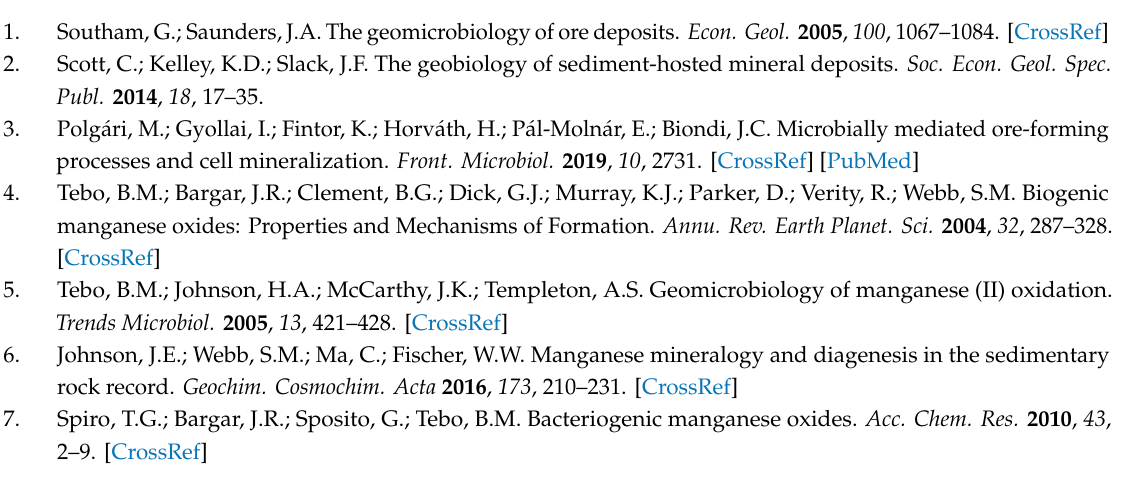
tu ff host (Vani vein / Figure 5). (B) MISS type: Nodules. Loaf- to mound-shaped structures with nodular and cauliflower-like thrombolytic surface fabric (VA-05-16 / Table S1). (C) MISS Type: Mat fragments and chips. Plan view of upper bedding surface of unmineralized sandstone / sandy tu ff covered by large patches of millimeter-thick Mn crusts, with highly irregular outlines and embayments, crosscut by white smoker–type hydrothermal-exhalative barite (-silica) feeder veinlets (black arrows). Chisel is 21 cm long (SMO-05-10 / Table S1). (D) MISS type: Mat-Layer Structure. Upper bedding surface showing “mat layer structure.” Concentric rims with crenulated appearance and discoidal colony texture (dotted line) (VA-05-05 / Table S1). (E) MISS type: Upturned and Curled Margins. Cracks with upturned and curled margins on upper surface of fine-grained Mn sandstone / sandy tu ff . Curved and upturned (involute) margin (arrow) of inferred fossil microbial mat consists of Mn-rich sandstone. Chisel in C is 21 cm (MI-04-27 / Table S1). (F) Mn sandstone / sandy tu ff -chimney. Tubular cone possibly representing a white smoker structure, consisting of erratic and locally patchy amounts of Mn oxides and barite that cement epiclastic sandstone / sandy tu ff ; knolls of Mn oxide minerals are adhering to the outer surface and tip of cone (VA-05-06 / Table S1). Number of analysed sample / Table with mineralogical composition or Figure with EPR analysis, Figure S2: Representative X-ray powder di ff raction pattern obtained for todorokite (T)-rich samples, Figure S3: Representative X-ray powder di ff raction patterns obtained for manjiroite(M)-rich samples [80], Figure S4: (A) SEM-backscattered electron (BSE) image of elongated fibres of crystalline todorokite ( > 5 µ m) intergrown within a platy todorokite matrix, which cement K-feldspar microclasts (K); (B) field-emission gun scanning electron microscope (FEG-SEM) image of nanocrystalline todorokite in the form of fibrous needles ( < 0.4 µ m) intergrown within a platy Mn oxide matrix; these fibres appear to be aggregated into a dense network of fibres displaying a plate-like growth morphology, which is characteristic of synthetic todorokite transformed from birnessite [75], Figure S5: FEG-SEM energy-dispersive spectrometer (EDS) image and Elemental maps of todorokite nanoplatelets. Image scale bar is 500 nm, Table S1: Powder X-ray di ff raction mineralogy of various Ore / MnMISS types, Table S2: SEM-energy-dispersive X-ray spectroscopy (EDX) spot analyses of crystalline todorokite (Figure S4B), Values in weight